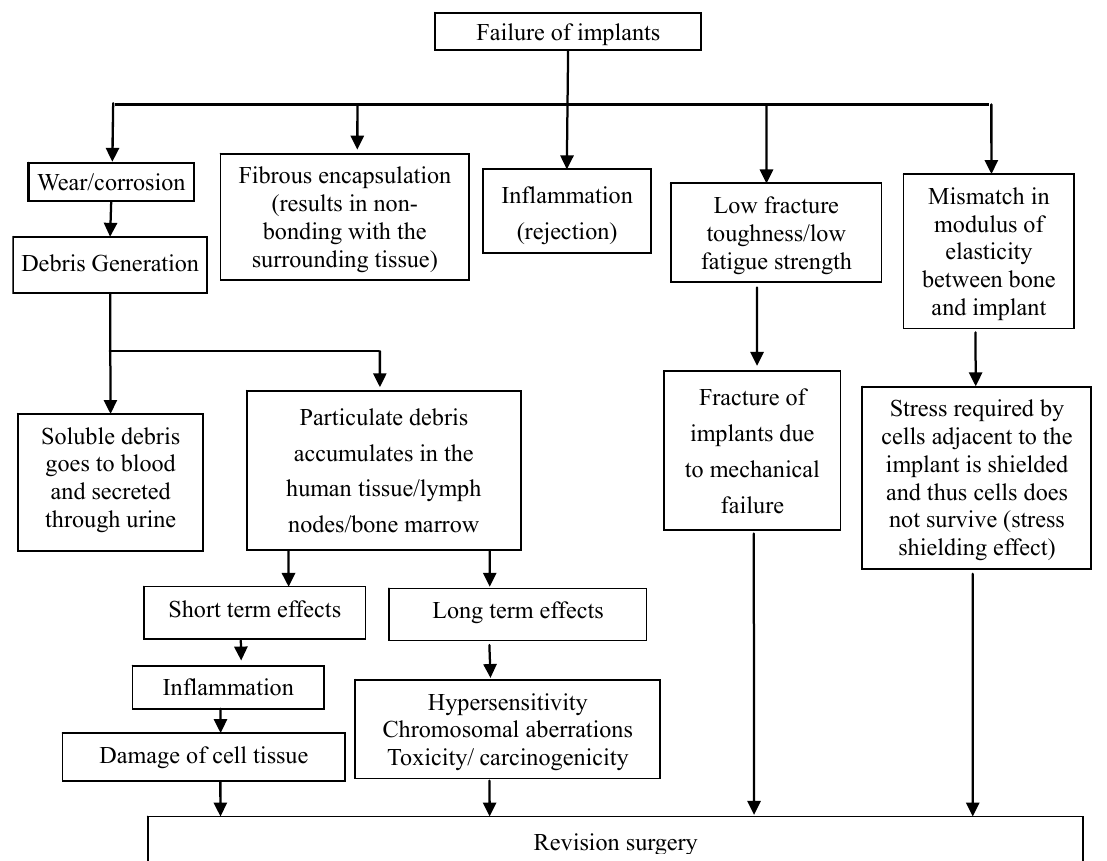
Figure 5. Various causes for failure of implants that lead to revision surgery [75]. Reprinted with permission from [75]. Copyright 2013